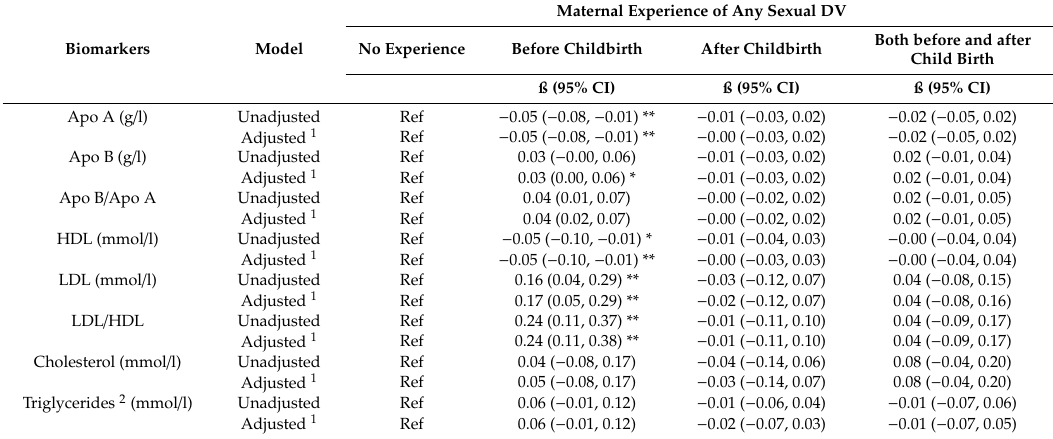
Table 4. Association of children’s level of lipid biomarkers with maternal experience of any sexual DV before and after